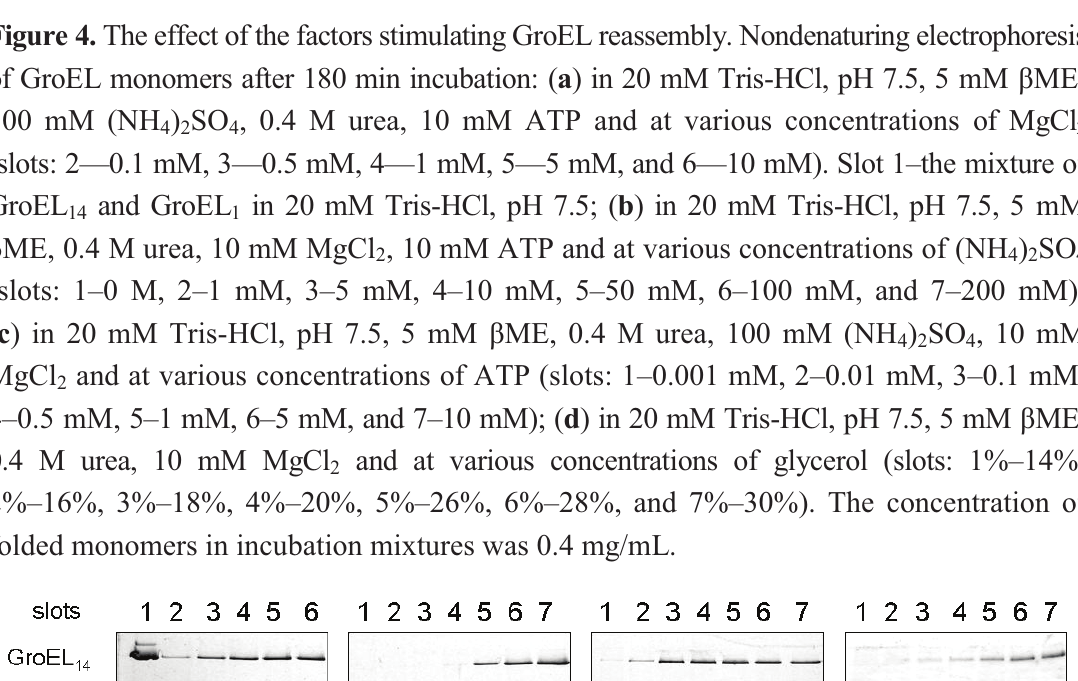
2 ) SO 4 2 4 ) SO , 10 mM 4 2 4